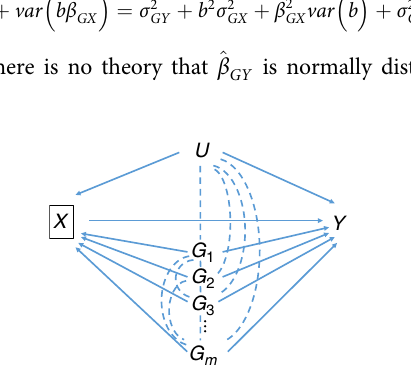
Fig. 3 Directed acyclic graph of association of SNPs G i with prognosis Y conditional on incidence X . U is as in Fig. 1. Conditioning on X induces the moralised associations shown by dotted lines. These create association of each G i with Y via the path G i (cid:2) U ! Y and all paths G i (cid:2) G j ! Y where i ≠ j . Under a polygenic model in which individual SNPs explain little covariation between X and Y , the combined effect of U and all G j ≠ i is approximately constant across SNPs G i . If a SNP G k has a major effect on X and/or Y , the associations of G j ≠ k can be conditioned on G k to prevent the major